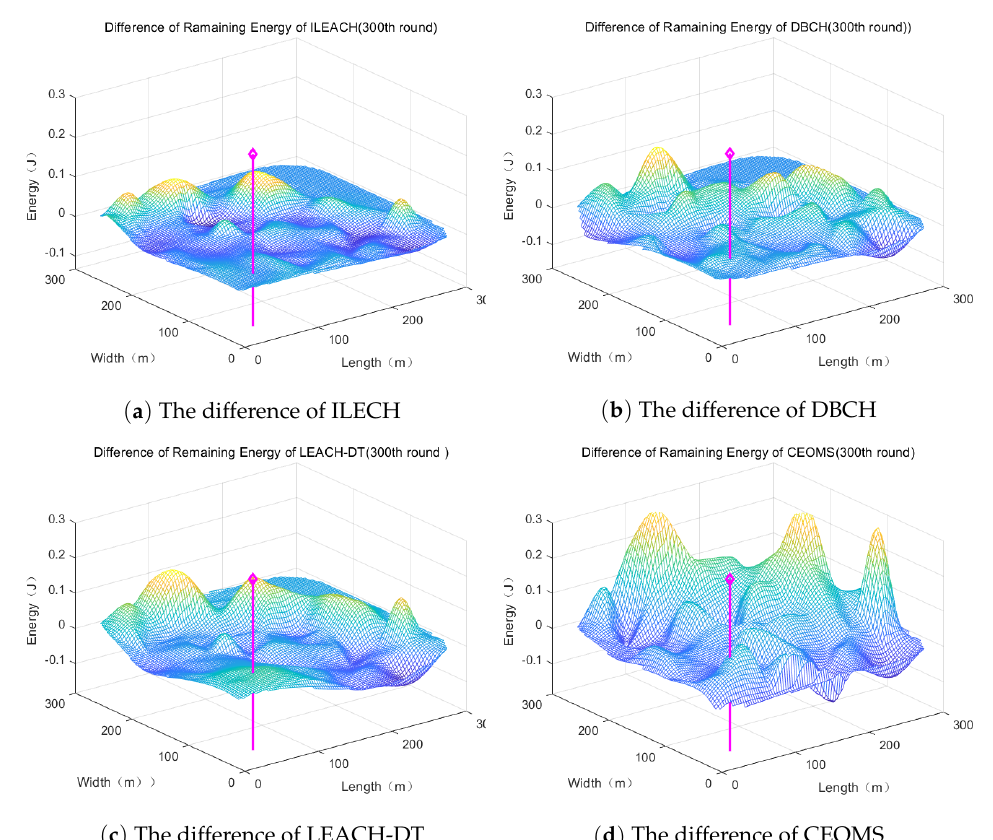
Figure 14. The difference of remaining energy distribution. It can be found that WSNs which used CEOMS algorithm had a larger surface fluc- tuation, which meant using the CEOMS algorithm could save the energy of the nodes. Moreover, at the 100th, 300th, 500th, 800th and 1000th round, the percentage of energy saving related to the four algorithms is described in the Figure 15.